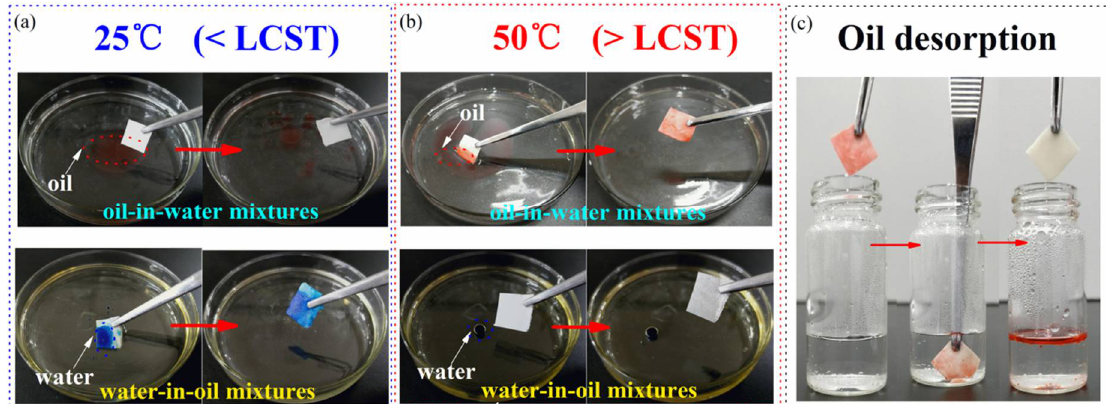
Figure 10. The adsorption behavior of cellulose- g -PNIPAAm paper in an oil/water mixture at 25 °C ( a ) and 50 °C ( b ), respectively. The inset of the top and bottom display the oil-in-water mixtures and water-in-oil mixtures, respectively. The paper pretreated with solutions of the oil layer (dyed red) on the water surface is shown in the top; the bottom shows the water droplet (dyed blue) under the oil; while there is depiction of the desorption behavior of the oil containing cellulose- g -PNIPAAm paper in 25 °C water ( c ).